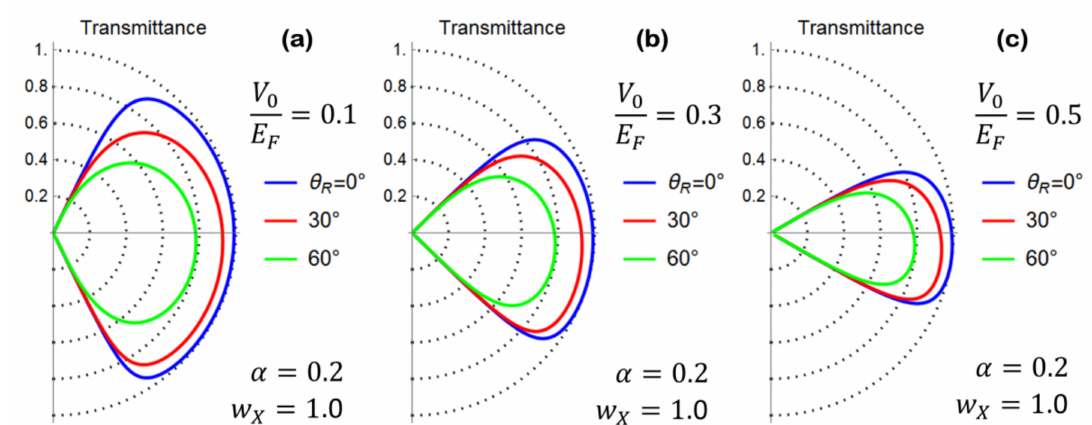
Figure 5. Polar plot of the transmittance of the n/n’ junction computed by setting the interface parameters as α = 0.2 and w X = 1.0. Different curves in each panel refer to different misorientation angles θ R , as indicated in the figure legend. The potential step has been fixed as V 0 panels ( a – c ), respectively. Due to the critical angle reduction for increasing values of V 0 , a suppression of the junction transmission at high incidence angles is clearly visible.